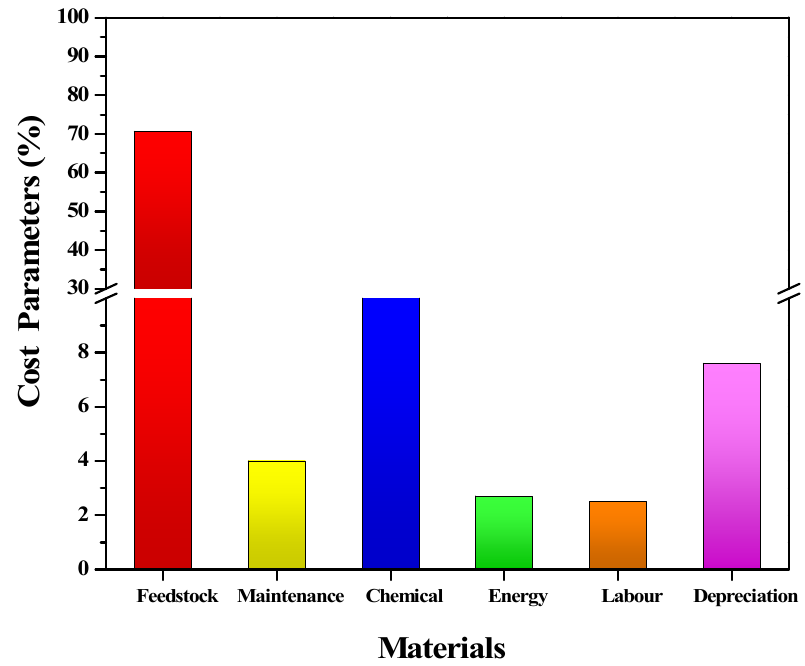
Figure 4. Parameters effecting the biodiesel production cost [93].